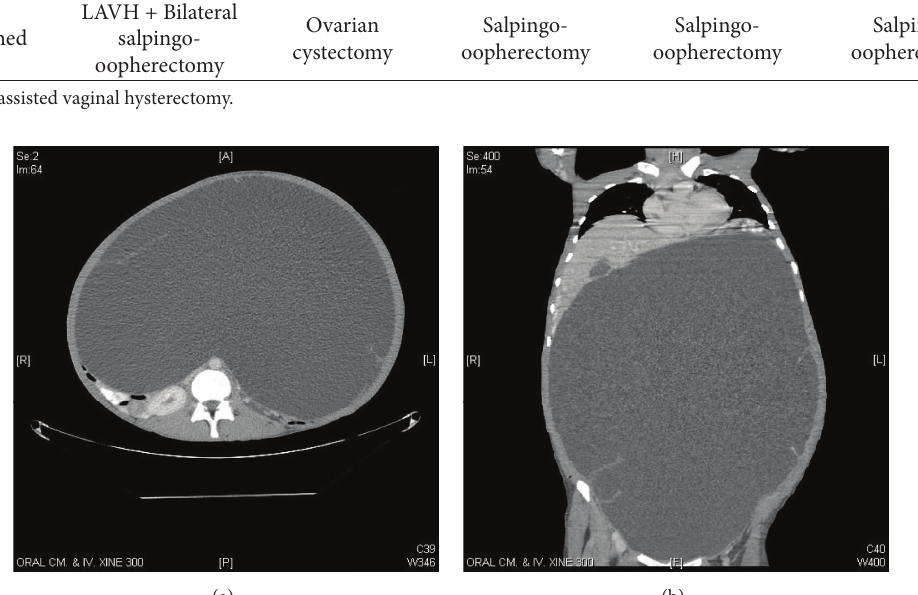
Figure 2: Axial and coronal computerized tomography (CT) scan images showing a huge ovarian cyst of patient 4.